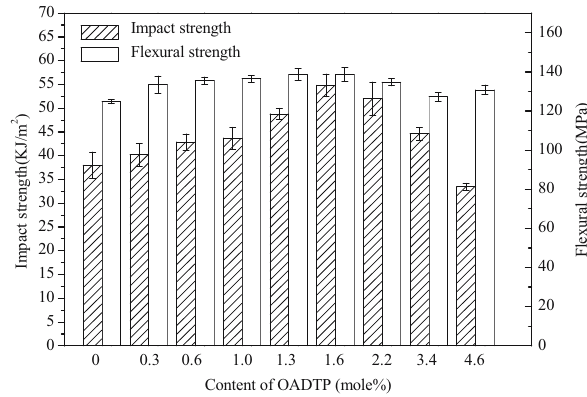
Figure 6: The mechanical properties of cured OADTP - PTA resins.